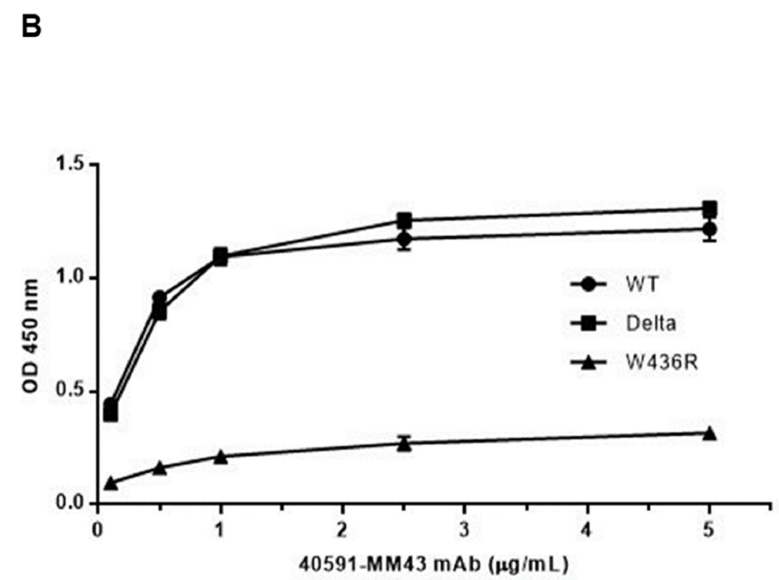
Figure 5. Binding activity of 40591-MM43 mAb to SARS-CoV-2 spike RBD WT, Delta, and W436R